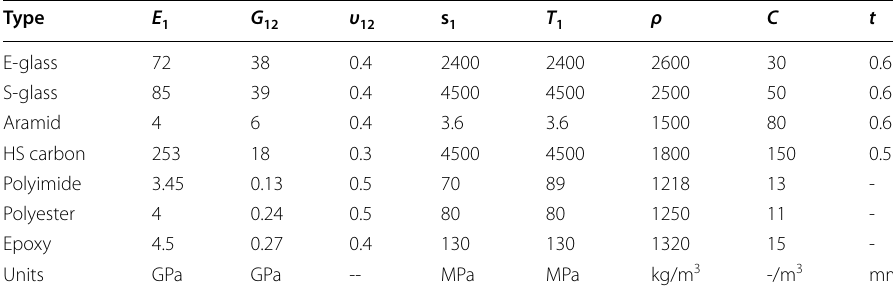
Table 2 Fiber and resin materials’ properties extracted from (courtesy [25])